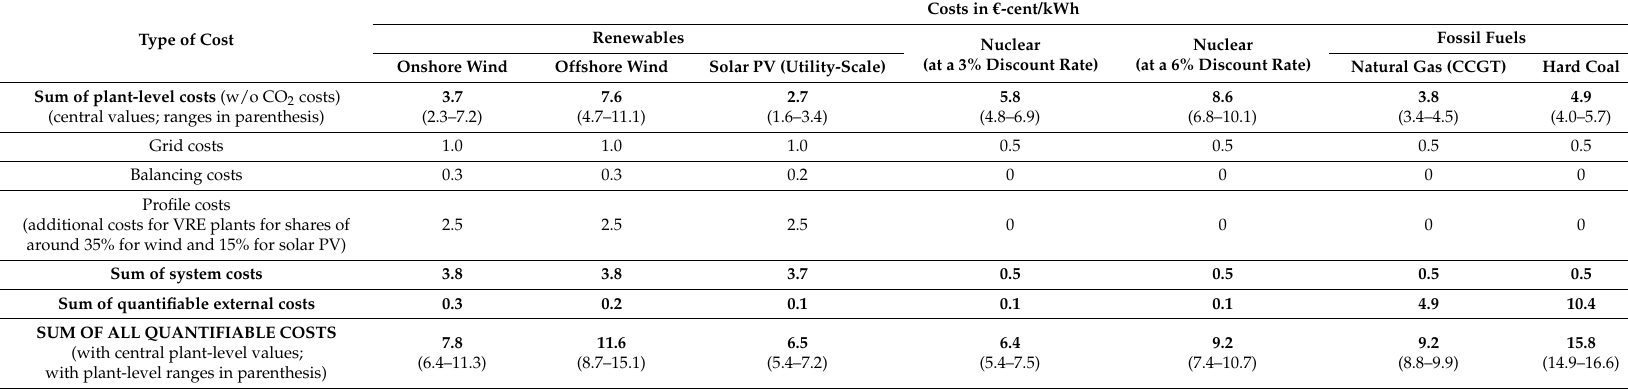
Table 15. Overview of the estimated specific social costs (central values) of electricity generation in Europe from several types of power plants built in 2040 depending on how profile costs are allocated. Costs in € -cent/kWh Renewables Nuclear Fossil Fuels Type of Cost Nuclear (at a 3% Discount Rate) (at a 6% Discount Rate) Onshore Wind Offshore Wind Solar PV (Utility-Scale) Natural Gas (CCGT) Hard Coal ...when all of the profile costs are allocated to VRE generation Sum of plant-level costs... ...when all of the profile costs are allocated to VRE generation Sum of system costs... ...when parts of the profile costs are allocated to baseload generation Sum of quantifiable external costs 0.5 0.2 0.1 0.1 10.4 ...when all of the profile costs are SUM OF ALL allocated to VRE QUANTIFIABLE COSTS...